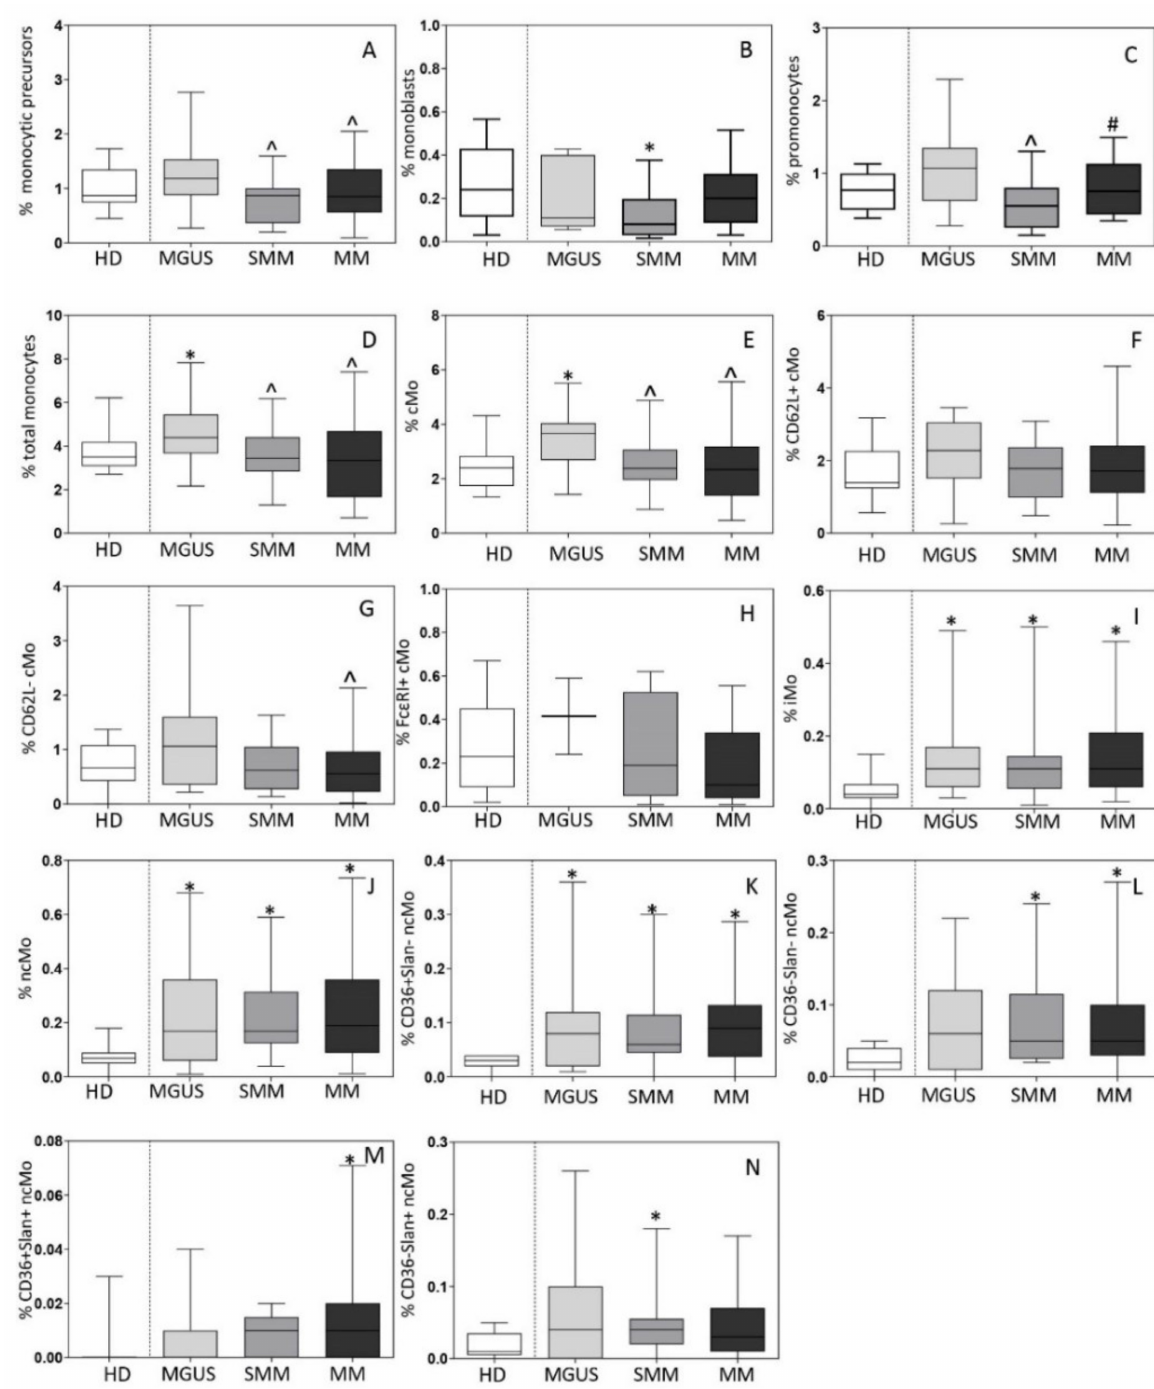
Figure 2. Distribution of monocytic precursors (total monocytic precursors, monoblasts and promonocytes; panels A – C ), total monocytes (Mo) (panel D ) and their subsets (panels E – N ) in bone marrow (BM) of newly-diagnosed MGUS ( n = 19), SMM ( n = 13) and MM ( n = 81) patients vs. age-matched HD ( n = 15). In panels A-N, notched boxes extend from the 25th to the 75th percentile values; the lines in the middle and vertical lines correspond to median values and the 5th and 95th percentiles, respectively. Statistical significant differences ( p ≤ 0.05) were observed vs. * HD, ˆ MGUS, and # SMM patients after applying the Mann–Whitney non-parametric test (as the KS normality test showed that data for these variables did not follow a normal distribution). cMo: classical monocytes; iMo: intermediate monocytes; ncMo: non-classical monocytes; HD: healthy donor; MGUS: monoclonal gammopathy of undetermined significance; SMM: smoldering multiple myeloma; MM: multiple